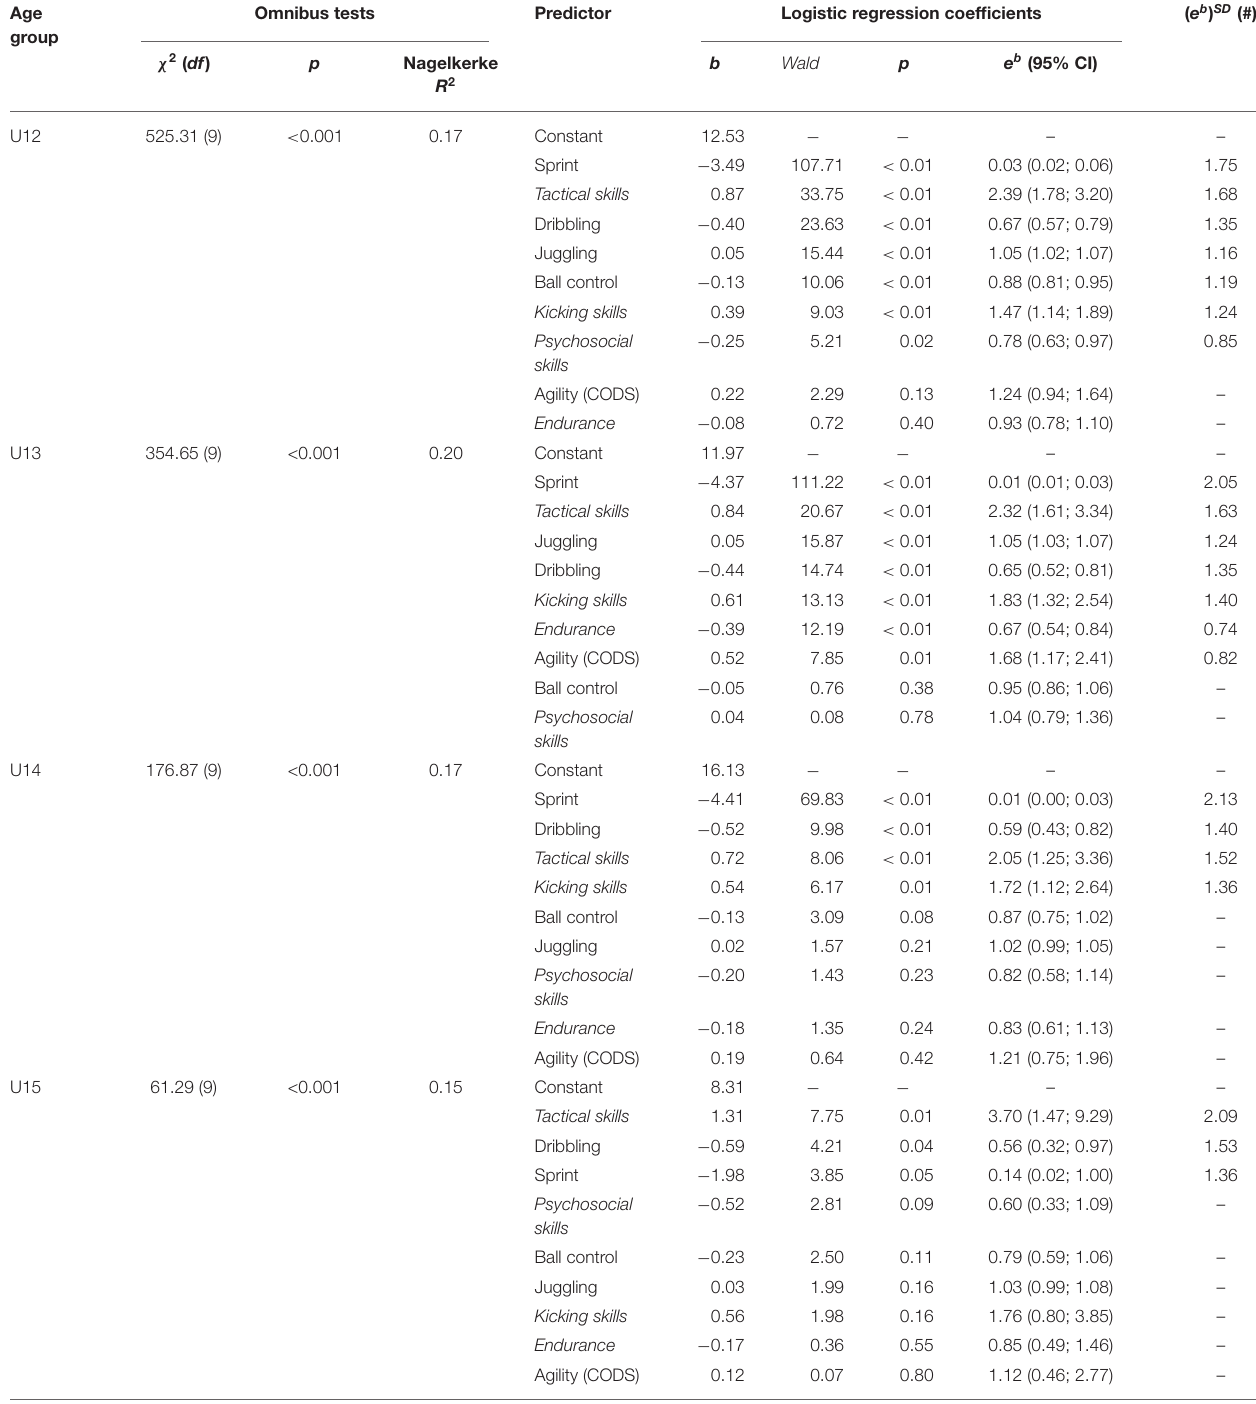
TABLE 4 | Logistic regression results for the prediction of players future success (selected for a YA three seasons later) in dependence of the subjective (printed in italics) and objective assessments (model 3, separated by age group). Age